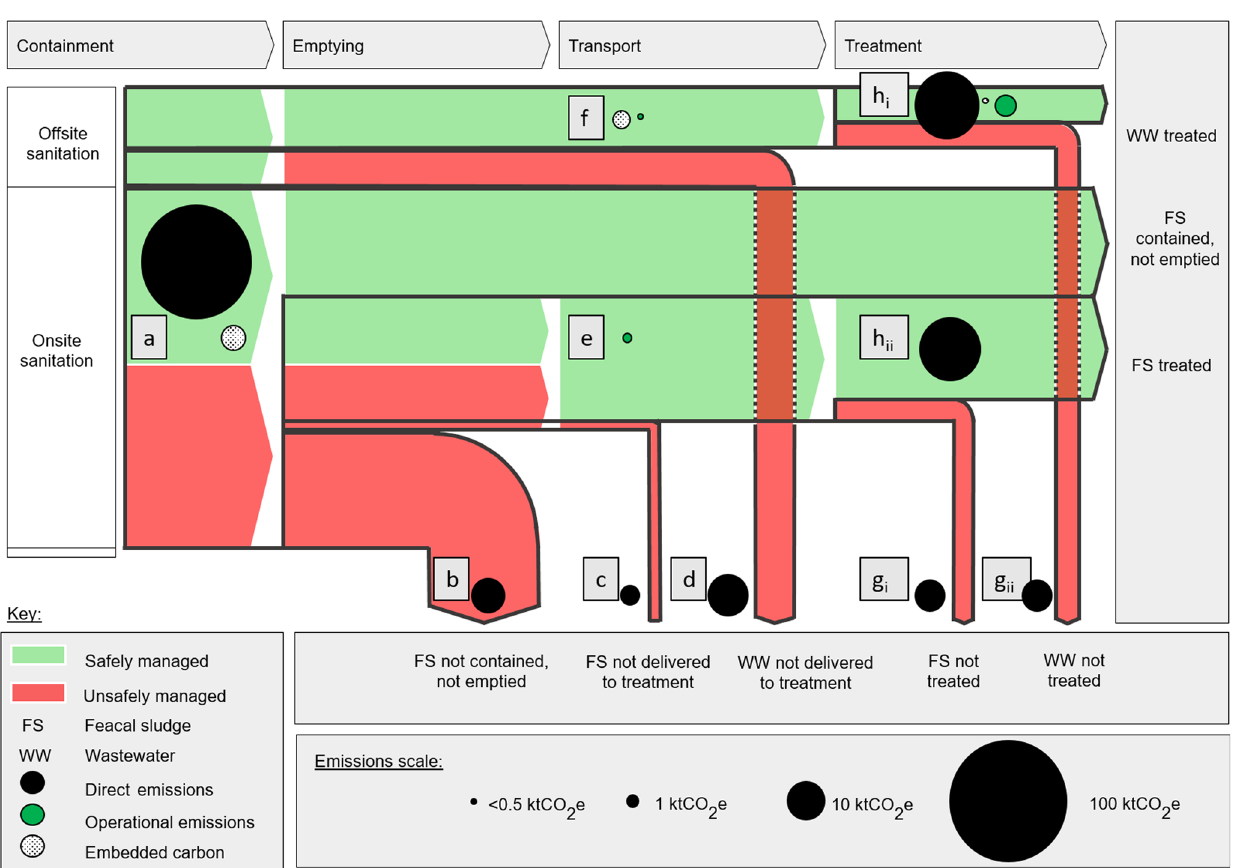
Fig. 4 Annual sanitation emissions for Kampala mapped to the excreta fl ow diagram. Total emissions from elements of the sanitation system in Kampala, showing direct emissions (black), operational emissions (dark green) and embedded carbon (grey). Area of circles indicates the scale of emissions in each case. Of the total emissions, 49% are from feacal matter-stored tanks and pits ( a ), 4% from discharges from tanks and pits direct to open ground or drains ( b ), 2% from illegal dumping of faecal waste ( c ), 6% leakage from sewers ( d ), a negligible amount (less than 1%) from transport of feacal waste by truck ( e ), 1% from transport of wastewater in sewers ( f ), 7% from wastewater and feacal sludge bypassing treatment ( g i + g ii ) and 31% from treatment plants ( h i + h ii